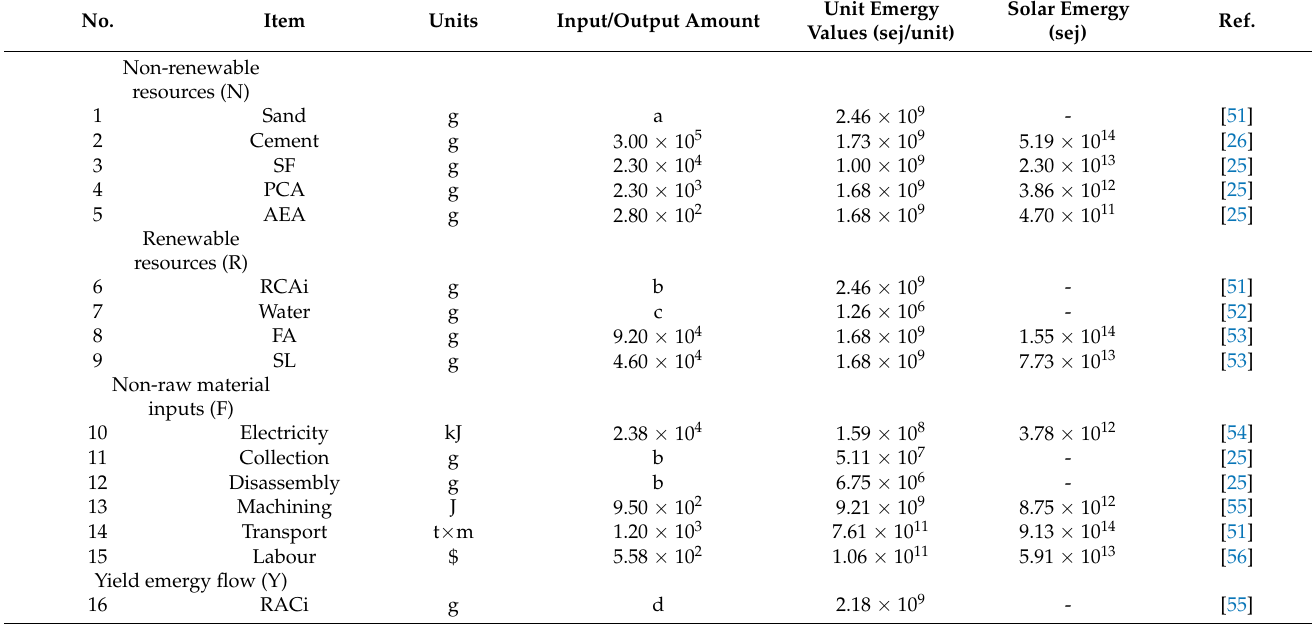
Table 6. Emergy evaluation form for the same items of RACi.